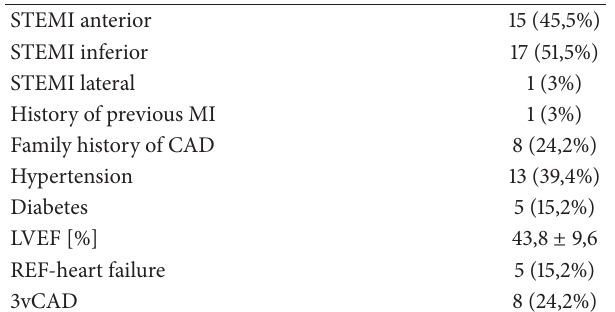
Table 3: Angiographic data of 33 STEMI patients.